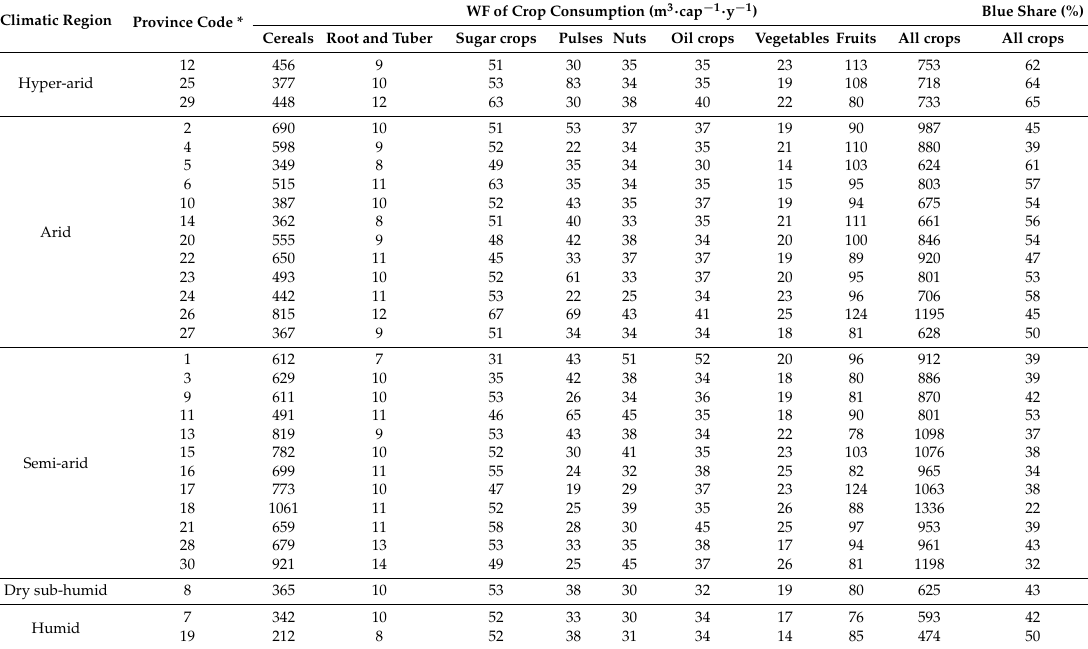
Figure 7. The 30-year average WF of Iranian crop consumption per capita, per province. Period: 1980–2010. The numbers in the map refer to the blue share in the WF of crop consumption. Table 4. The 30-year average water footprint of crop consumption per capita and the blue share in the total, per province and crop category. Period: 1980–2010. Climatic Region Province Code *